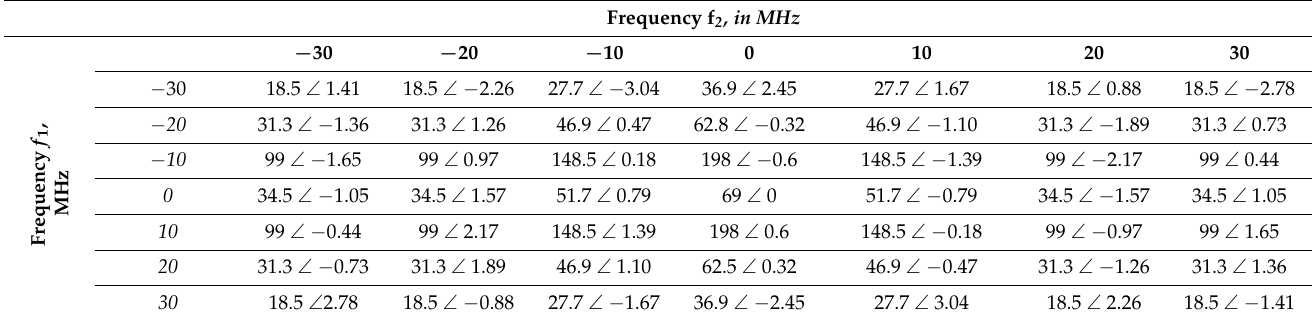
Table 1. The amplitudes and phases of the bifrequency spectrum. Frequency f 2 , in MHz